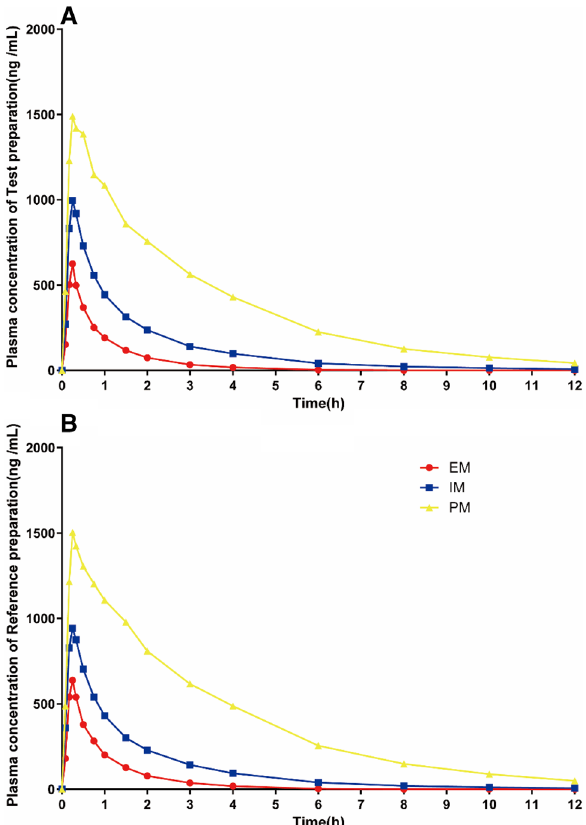
Figure 3. Plasma test ( A ) and reference, ( B ) preparation concentrations-time profiles in relation to CYP2C19 phenotypes. (PK = pharmacokinetic, PM = poor metabolizer, IM = intermediate metabolizer, EM = extensive